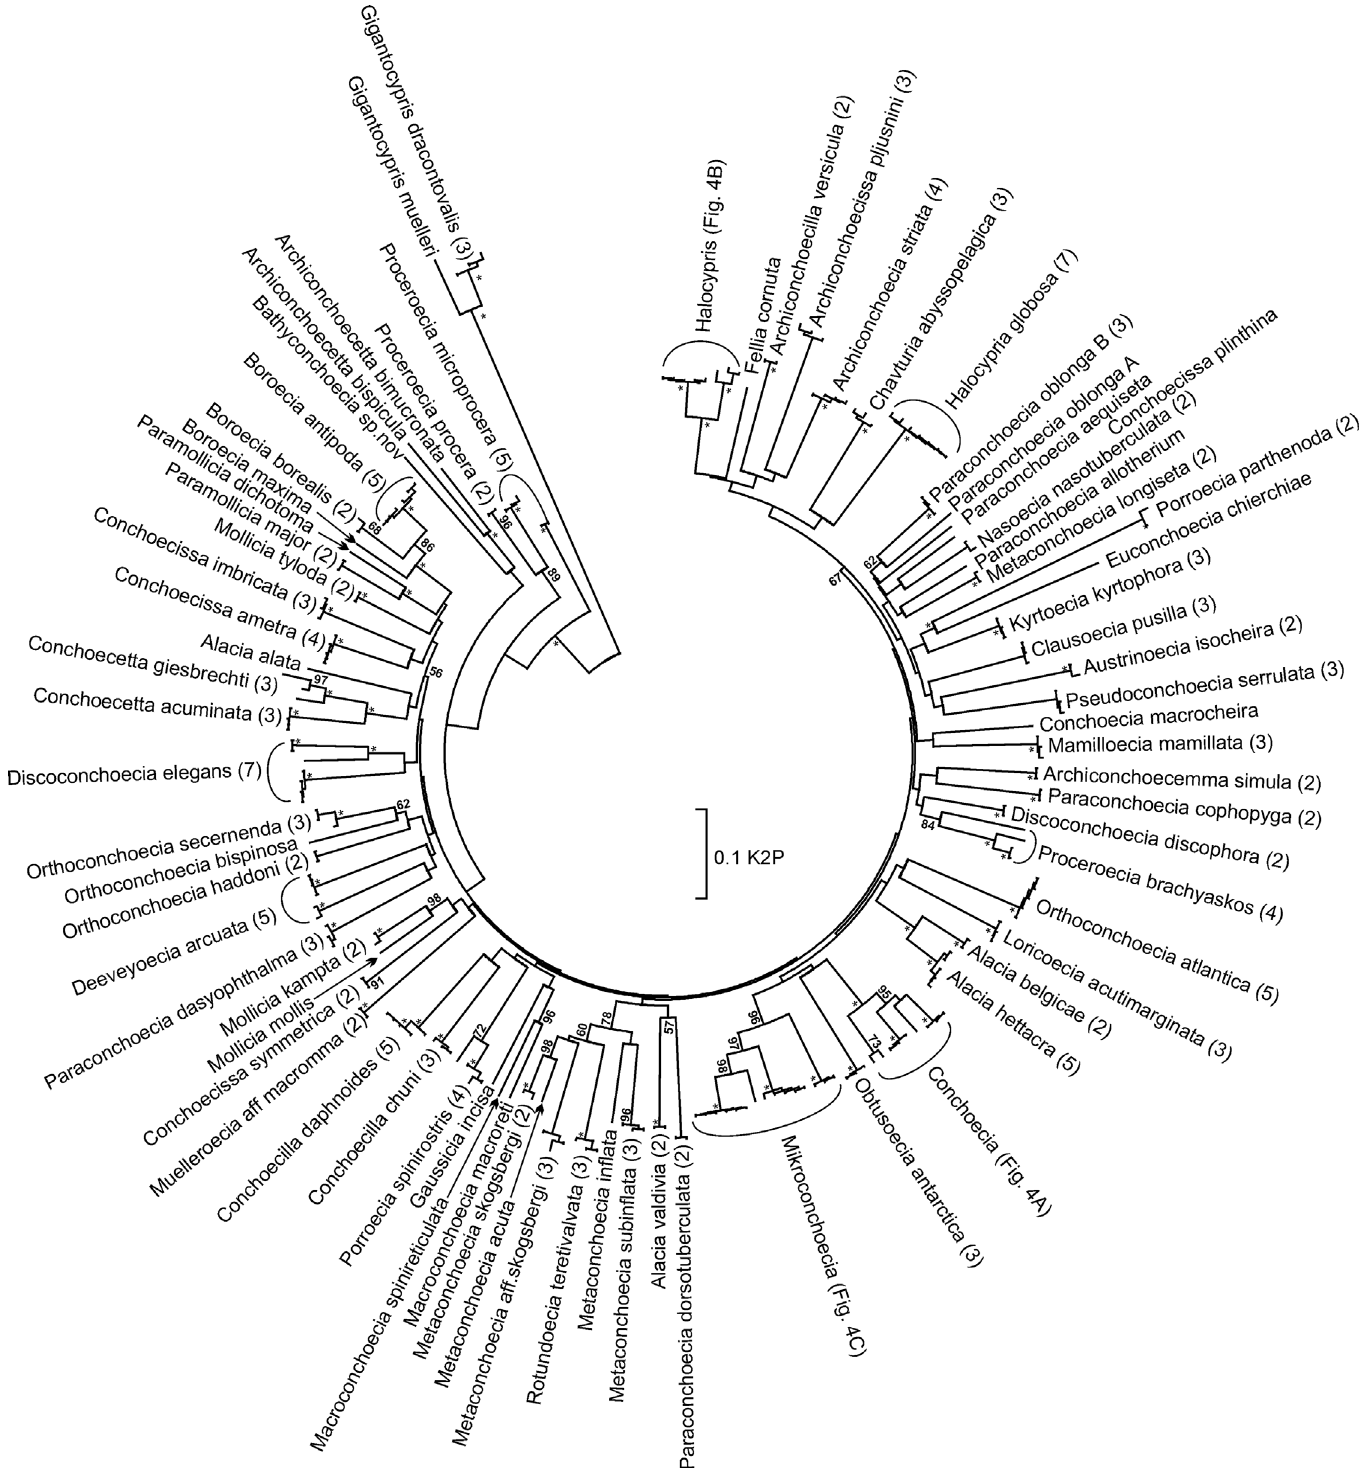
Fig 3. COI gene tree for specimens of planktonic marine ostracods analyzed in this study. Neighbor Joining gene tree based on COI barcode region sequences for 210 specimens of 78 species of ostracods. Analysis used Kimura-2-Parameter distances; bootstrap values > 50% for 1,000 sub-replicates are displayed at nodes; bootstrap values = 99% are indicated by an asterisk ( *